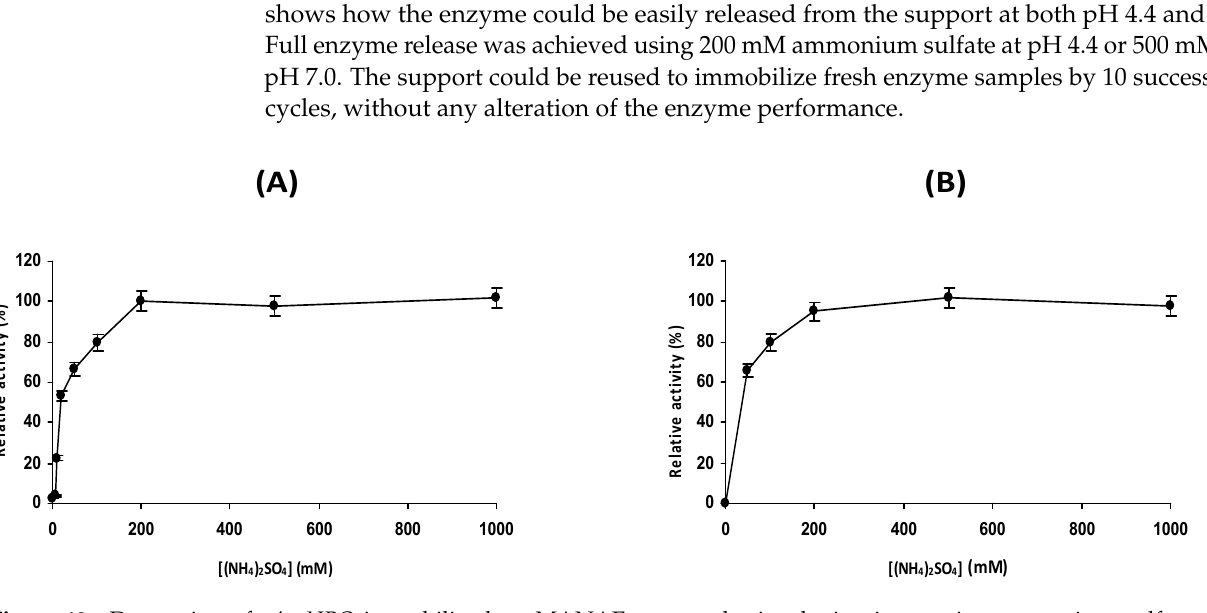
Figure 13. Desorption of rAaeUPO immobilized on MANAE support by incubation in growing ammonium sulfate concentration at pH 4.4 ( A ) and 7.0 ( B ). The experiments were performed as described in the Methods section.